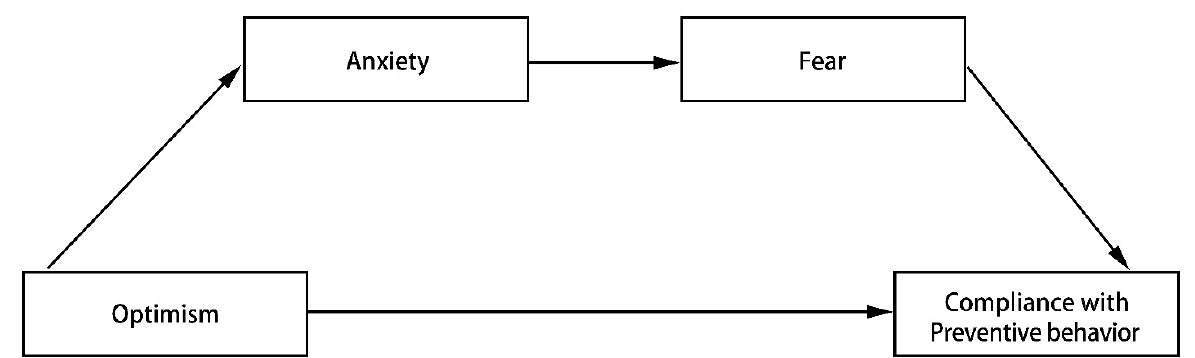
Figure 4. Conceptual model, the indirect effect of optimism on compliance with preventive behaviors via anxiety and then fear.